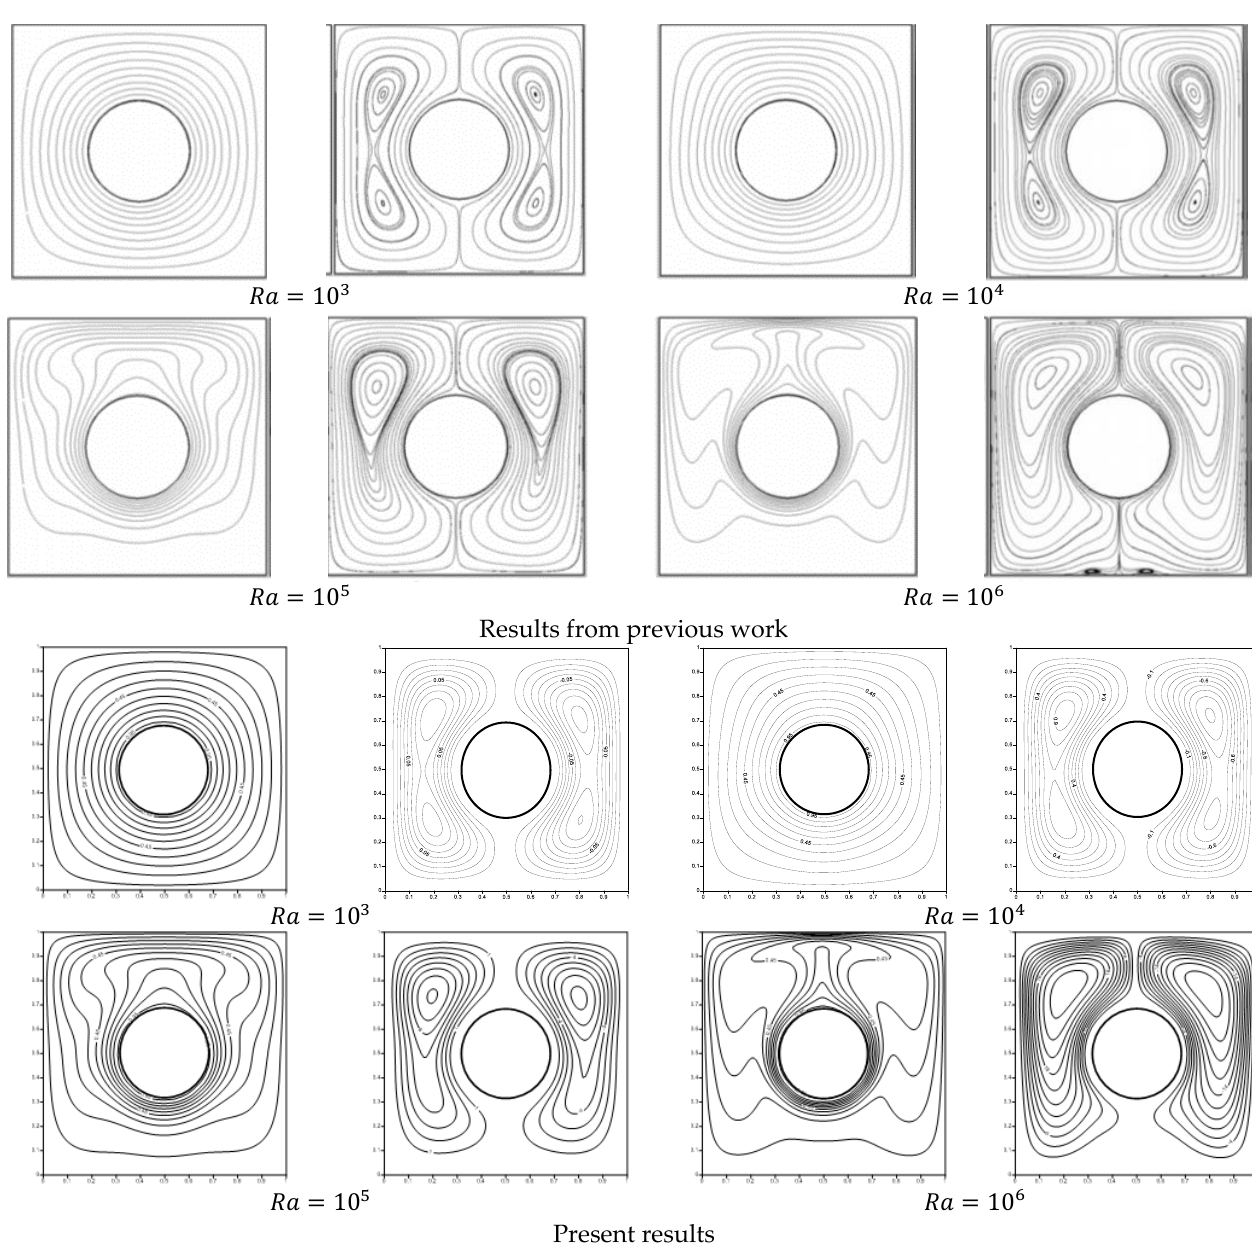
Figure 3. Comparison of isothermal lines and streamlines for four different Rayleigh numbers from [44] and the present work.